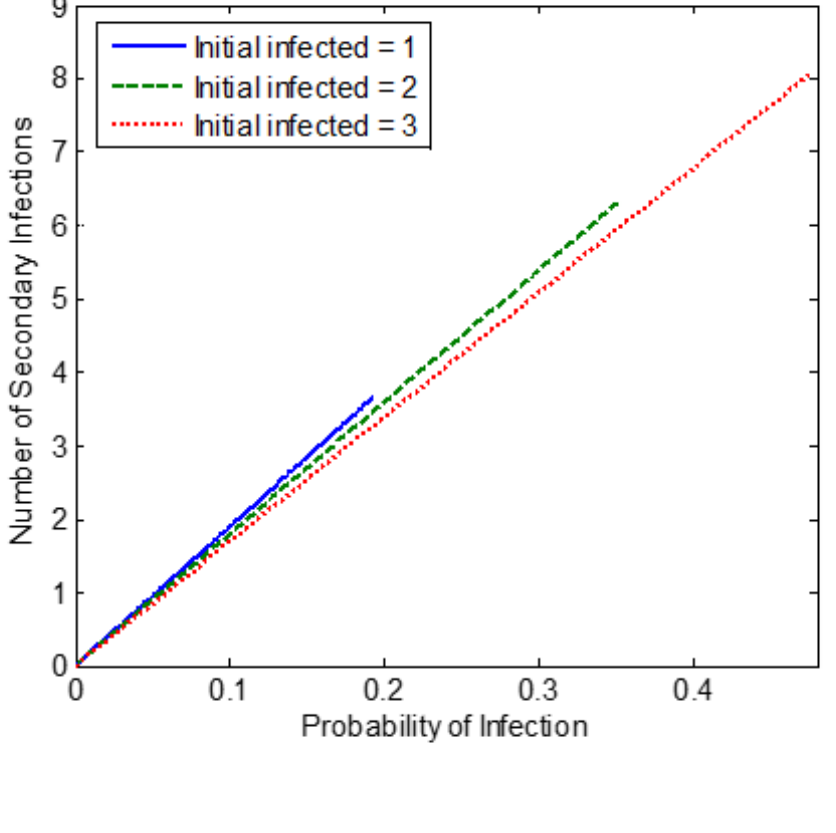
Figure 8. The number of secondary infections in the bus due to the introduction of infected individuals into the susceptible population (total population of N = S + I = 20), shown as a function of the estimated probability of